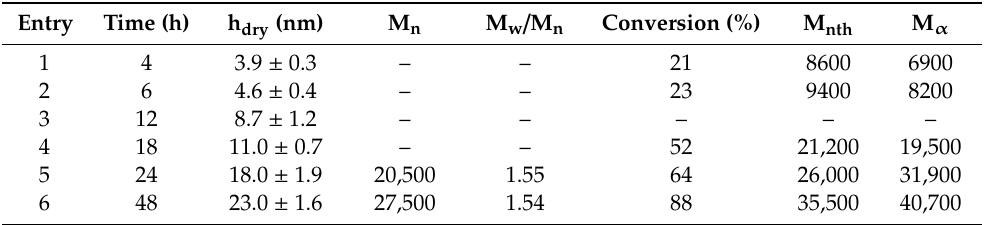
Figure 1. AFM topography images at the edge of the scratches performed in poly(methyl methacrylate) (PMMA) brushes obtained after different times of surface-initiated photoinduced iron-catalyzed atom transfer radical polymerization (SI-photo-Fe-ATRP) in the presence of the sacrificial initiator. Table 1. Results of syntheses of poly(methyl methacrylate) (PMMA) brushes via surface-initiated photoinduced iron-catalyzed atom transfer radical polymerization (SI-photo-Fe-ATRP) with the sacrificial initiator.